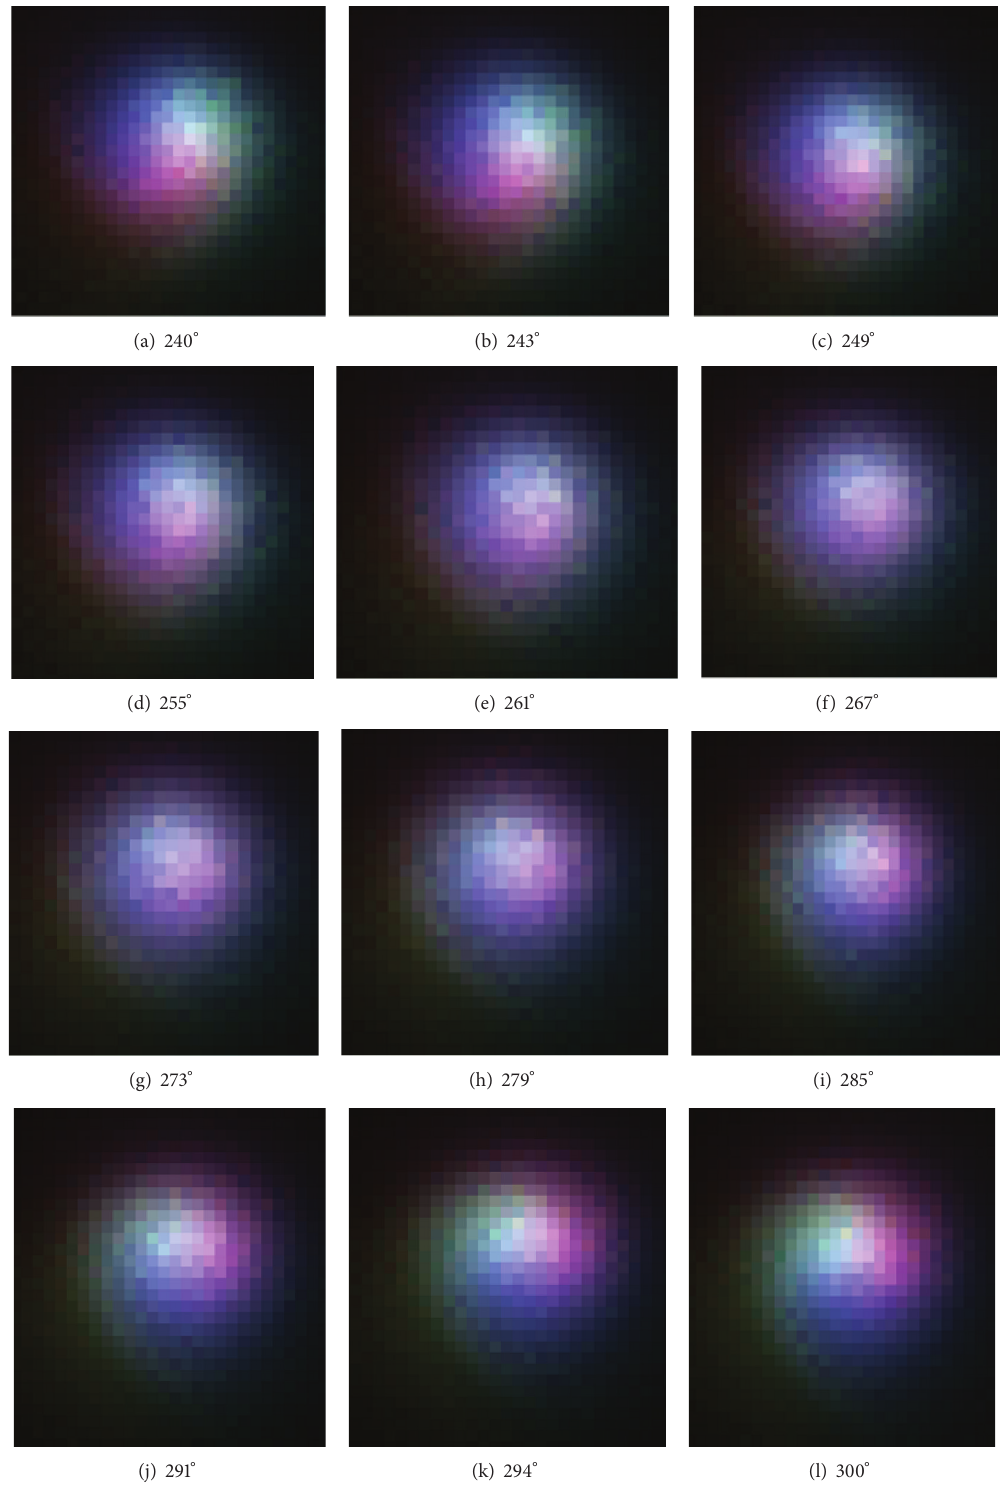
Figure 19: RGB LEDs can be combined to produce white